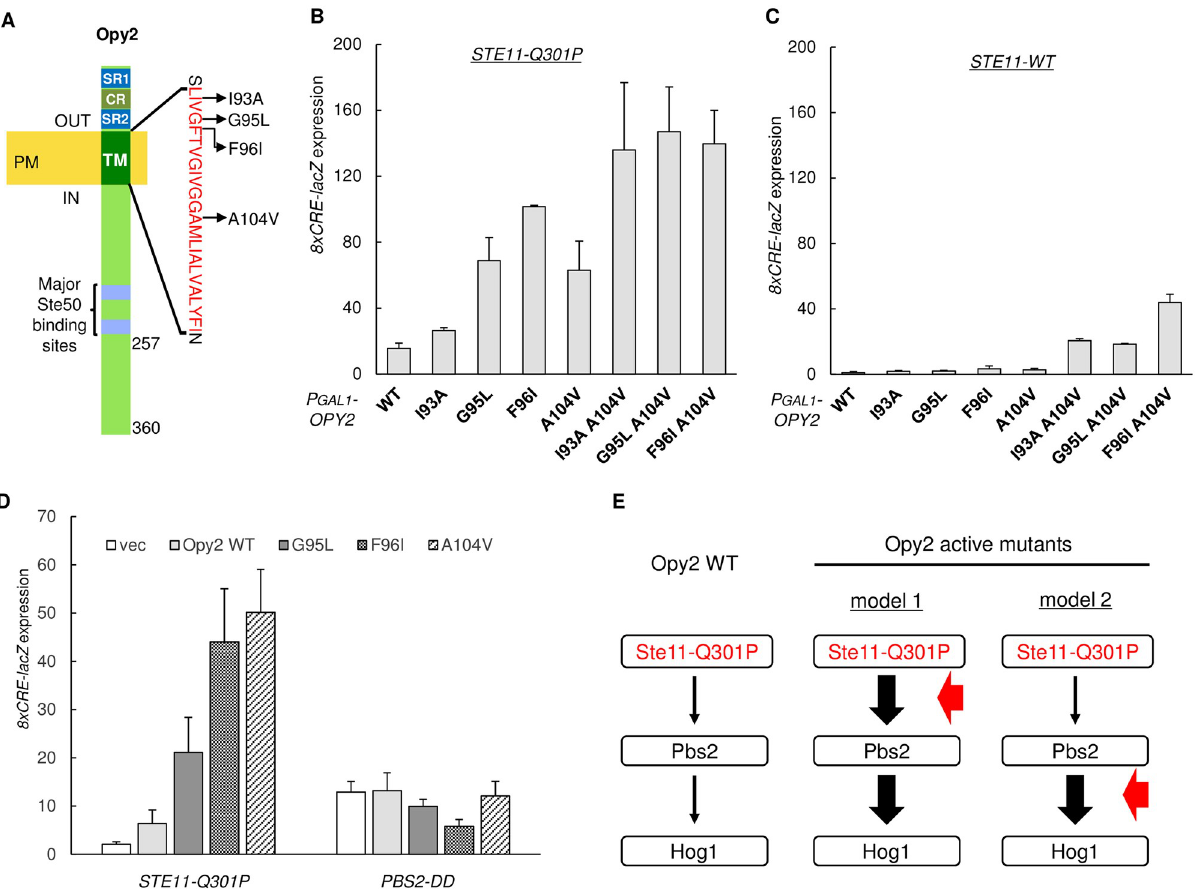
Fig 2. Isolation of Opy2 hyperactive mutants that have mutations in the TM domain. ( A ) Schematic structure of Opy2. Numbers indicate amino acid positions. The amino acid sequence of the TM domain is shown in red using the one-letter code. SR1 and SR2, Ser-Rich domain 1 and 2; CR, Cys- Rich domain, TM, transmembrane domain; PM, Plasma Membrane; ( B-D ) Expression of the Hog1-specific reporter gene 8xCRE-lacZ . β -galactosidase activity is expressed in Miller units. Error bars represent S.D. (n � 3). (B, C) The yeast strain KY517 ( ssk2/22 Δ opy2 Δ STE11-Q301P ) (B), or KY477 ( ssk2/22 Δ opy2 Δ ) (C) was transformed with a reporter plasmid carrying the 8xCRE-lacZ gene and another plasmid that expresses the indicated Opy2 ). Transformed cells were grown in CARaf, and expressions of Opy2 mutants were induced by 2% galactose mutants from the GAL1 promoter (P GAL1 for 2 hr, following which cell extracts were prepared for reporter assays to determine the expression of the 8xCRE-lacZ gene. (D) Hog1-specific reporter assays were conducted as (B, C), except that the yeast KT265 ( ssk2/22 Δ opy2 Δ pbs2 Δ ) was transformed with a single copy plasmid that expressed the Pbs2-S514D T518D mutant from its native promoter in addition to both a reporter plasmid carrying the 8xCRE-lacZ gene and an Opy2 mutant plasmid. (E) Signal flow in the Hog1 MAPK cascade initiated by the constitutively-active Ste11-Q301P. Without hyperactive OPY2 mutation, activation of Hog1 is very weak (left panel). Hyperactive OPY2 mutation might enhance the signaling between Ste11 and Pbs2 (middle panel) or that between Pbs2 and Hog1 (right panel). Vertical arrows indicate signal flows, whereas the horizontal red arrows indicate the site of action of the hyperactive OPY2 mutations.